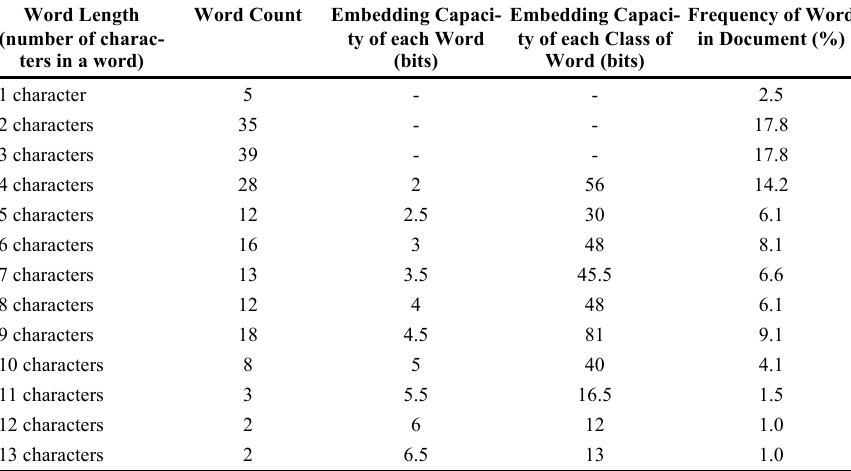
Table 1. Word count statistics of test